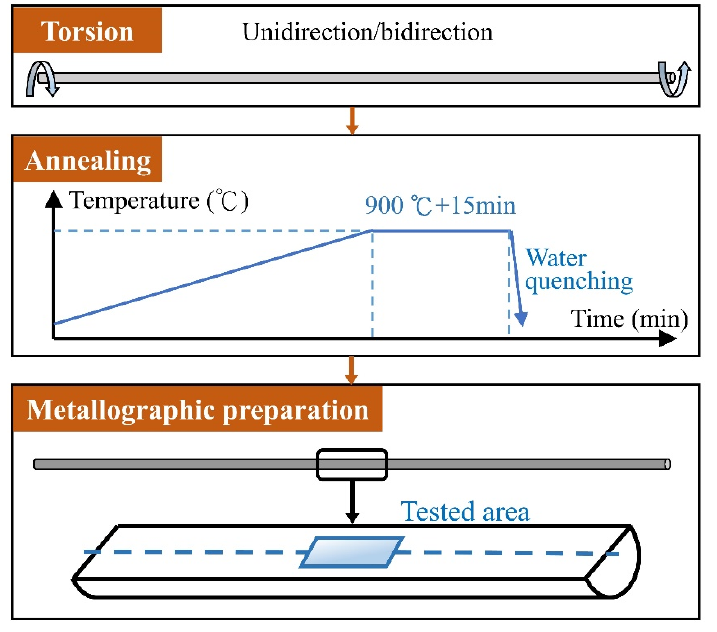
Figure 1. Schematic diagrams of the TMP and the metallographic preparation. Rough grinding and mechanical polishing were conducted on all samples to obtain the observation surfaces. Subsequently, samples were electro-polished in the solution of 30% H 2 O + 70% H 2 SO 4 with 12 V direct current for 12 s at room temperature. The electro- polish technique could remove residual stress of the observation surfaces. Then, samples were analyzed by a JSM-7800F scanning electron microscope equipped with an electron backscatter diffraction (EBSD) instrument set. Each scanning area was 600 µ m × 400 µ m and the step size was 1 µ m. The crystallographic orientation data were analyzed in CHANNEL 5 and MATLAB software. In this research, the GB with a misorientation greater than 15 ◦ was recognized as a high-angle boundary. Brandon criterion was used to identify the CSL boundaries [23]. Grain size was measured by the linear intercept method. Vickers hardness tester HVS-1000A was employed to do hardness tests with a load of 0.5 kg and a dwell time of 10 s. For each sample, at least 5 hardness indentations were obtained, and the average value was taken as the final result. Tensile tests were conducted by a CMT5105 electronic universal material testing machine at room temperature. The gauge length was 100 mm, and the tensile speed was 2 mm/min. Each group of tensile tests was repeated 3 times to reduce the